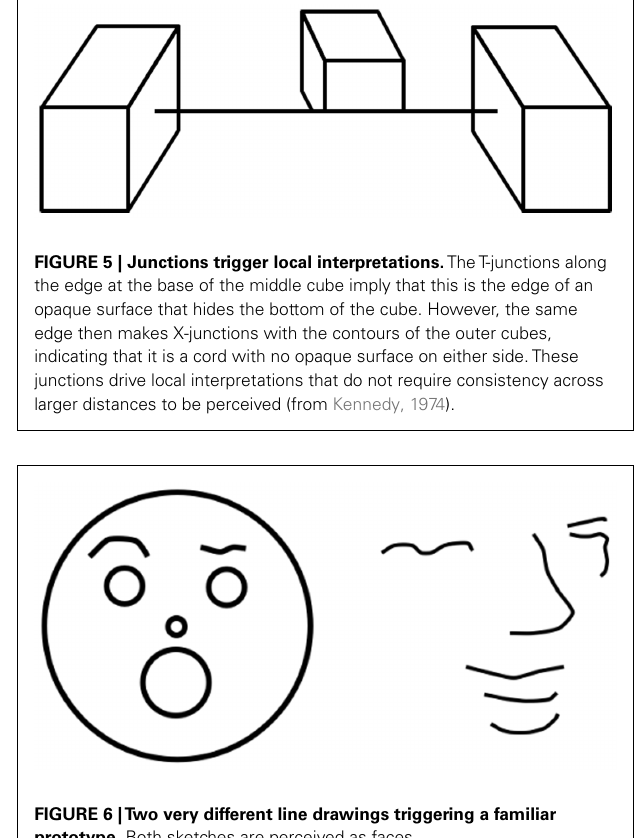
FIGURE 6 |Two very different line drawings triggering a familiar prototype. Both sketches are perceived as